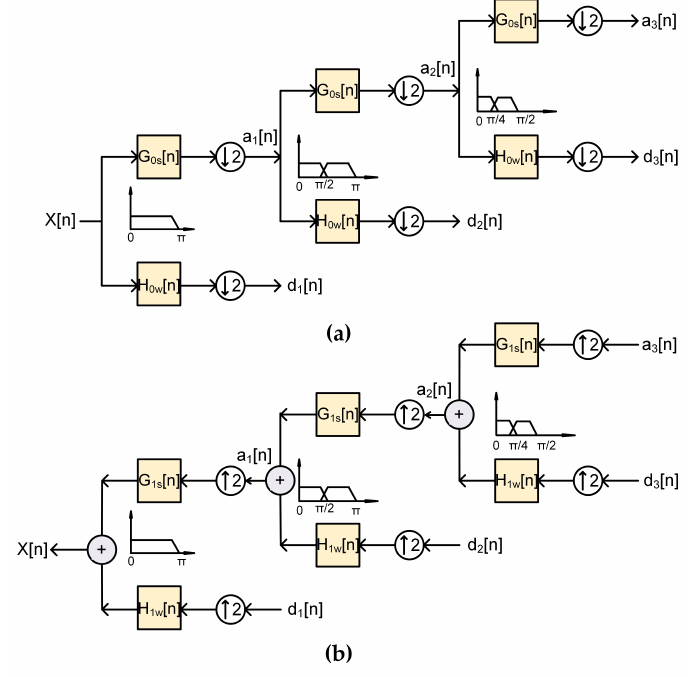
Figure 3. Wavelet Transform using Mallet Tree: ( a ) Decomposition, ( b )